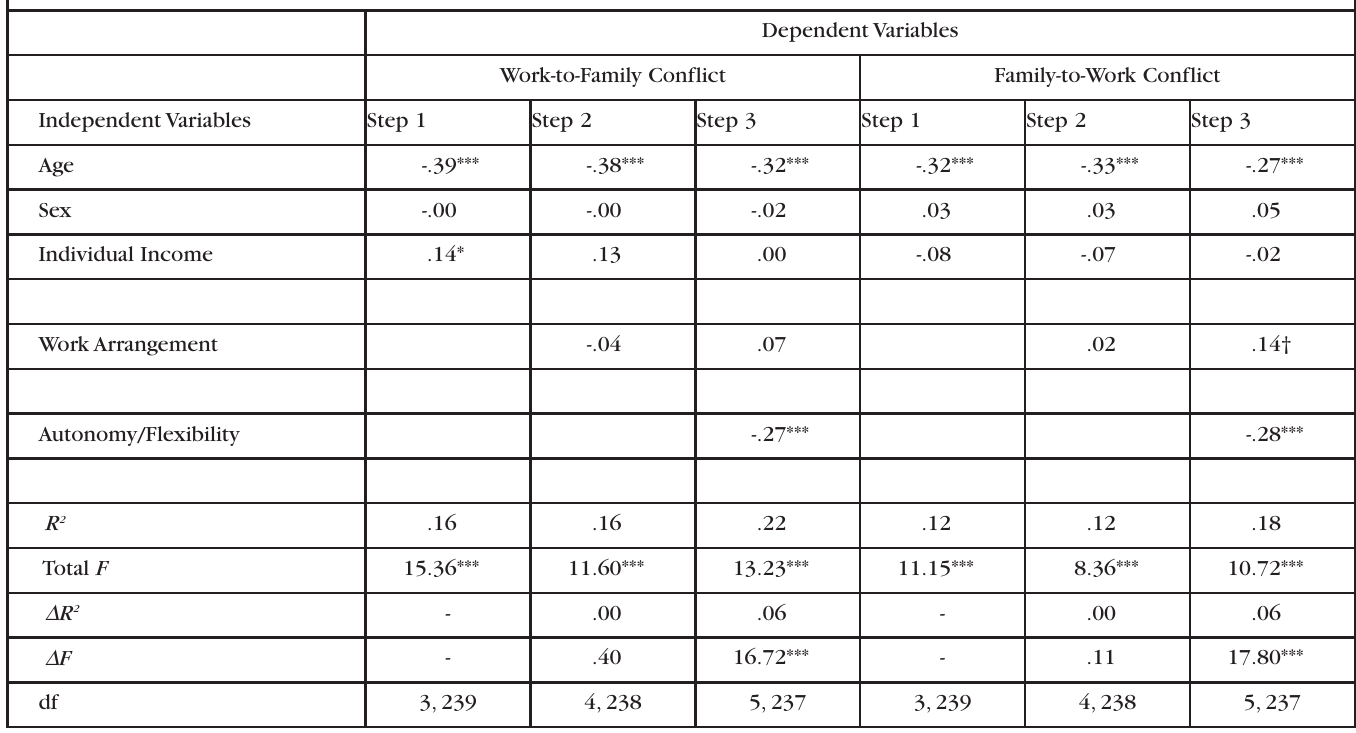
Table 2a. Hierarchical Regressions on Work-to-Family and Family-to-Work Conflict Dependent